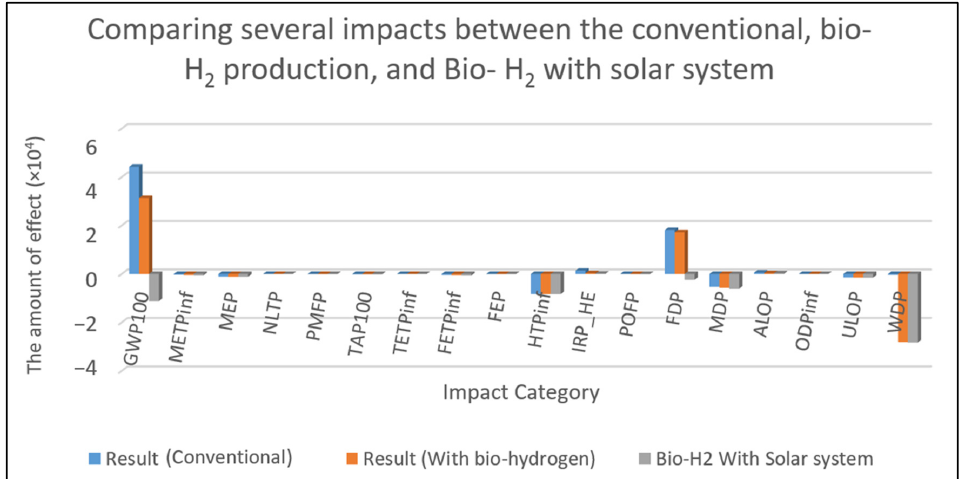
Table 11. Comparison of the LCIA with/without solar energy.